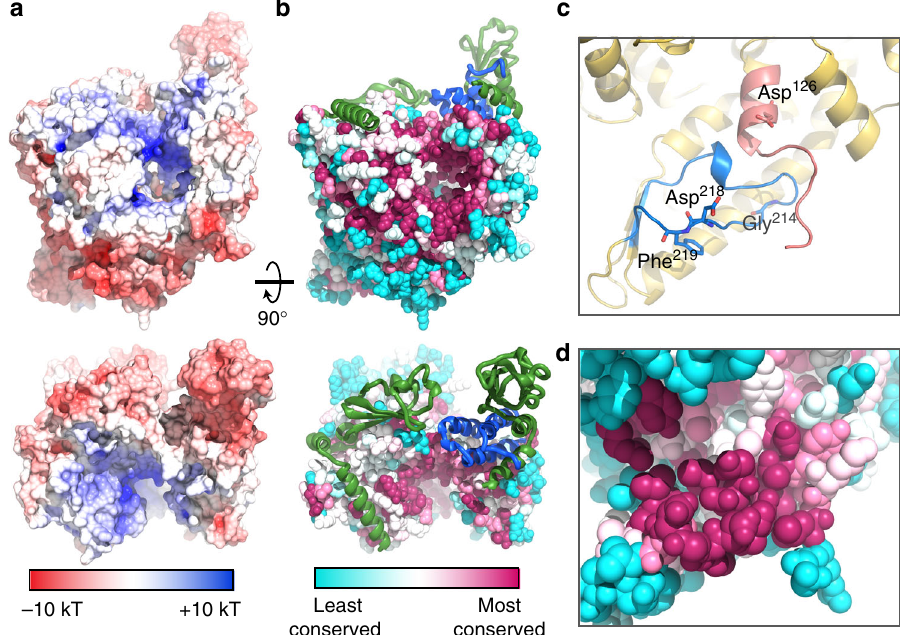
Fig. 2 Surface electrostatics and sequence conservation of the nsp7-nsp8-nsp12 complex. a The RNA-binding cleft of SARS-CoV nsp7-nsp8-nsp12 is positively charged while the remaining protein surface carries a negative charge. b Sequence conservation 53,54 across the coronavirus family indicates a high level of conservation in the polymerase-active site and nsp7-nsp8 heterodimer-binding site with the binding site of the single nsp8 subunit less conserved. c , d Sequence motifs of the NiRAN domain 9 form a single surface on nsp12 (yellow). Motif C N (blue) and the C-terminal portion of motif B N (pink) are observed in the structure. Amino acids conserved across the Nidovirales order are shown as sticks. Coloring in d is the same as in